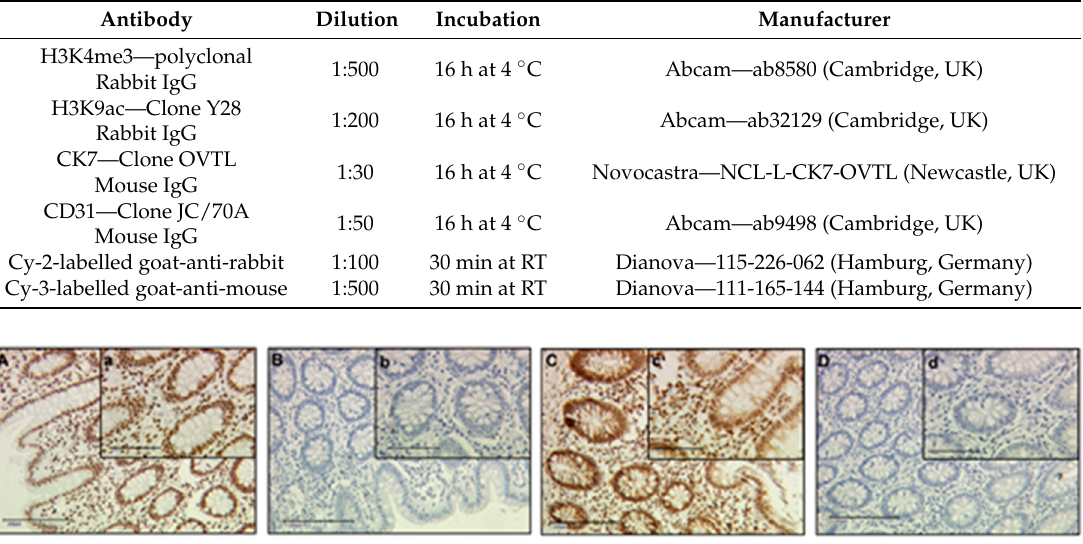
Figure 6. Positive and negative immunohistochemistry staining controls. Colon tissue was used as positive ( A , a ) as well as negative ( B , b ) control for H3K9ac antibody. For the H3K4me3 antibody, colon tissue was used as positive ( C , c ) as well as negative ( D , d ) control, as well. Negative control serum was added to the tissue for negative control staining. Brown staining indicates primary and secondary antibody binding, blue staining is due to haemalaun counter staining. Pictures were taken at a 100 × (capital letters) and 250 × (lower-case letters) magnification,